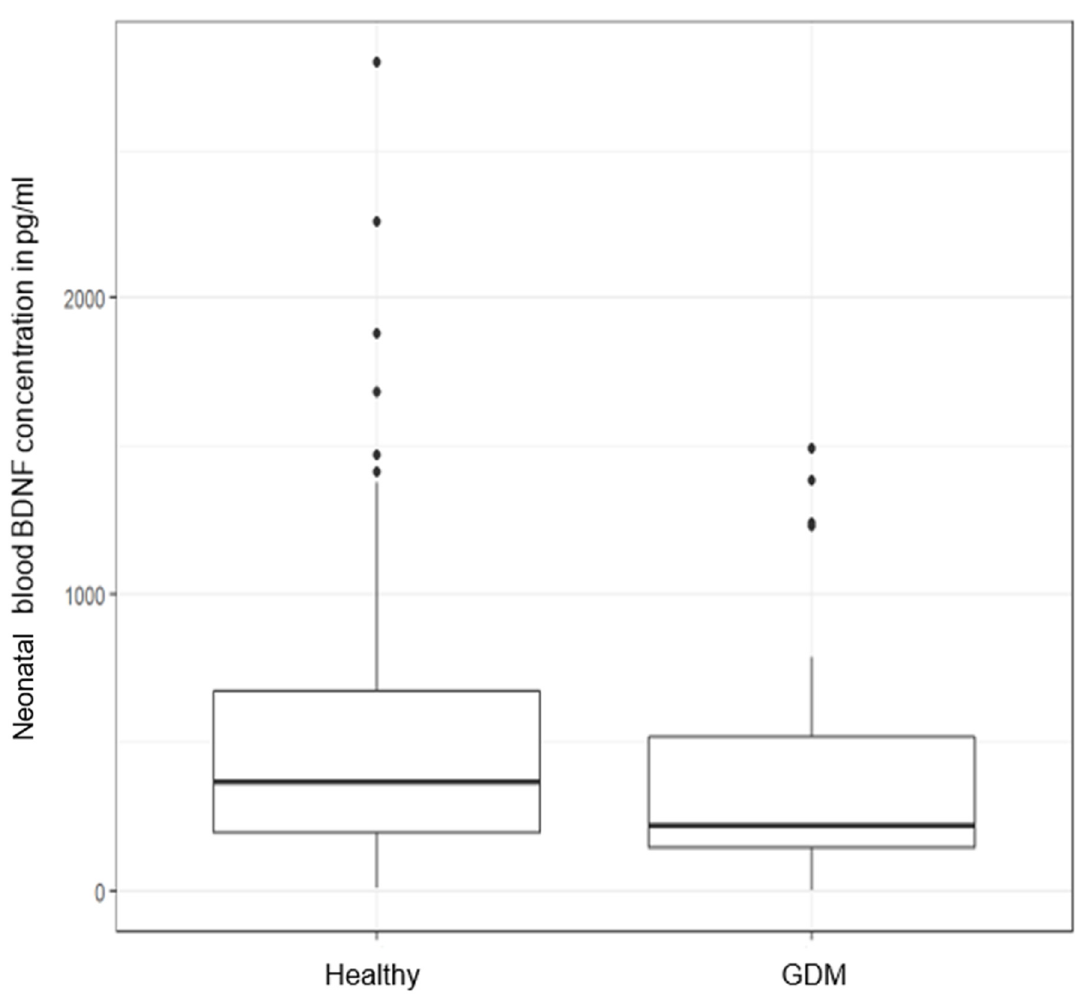
Figure 4. BDNF concentration (pg/mL) in neonates of mothers with GDM and metabolically healthy controls ( p = 0.027).